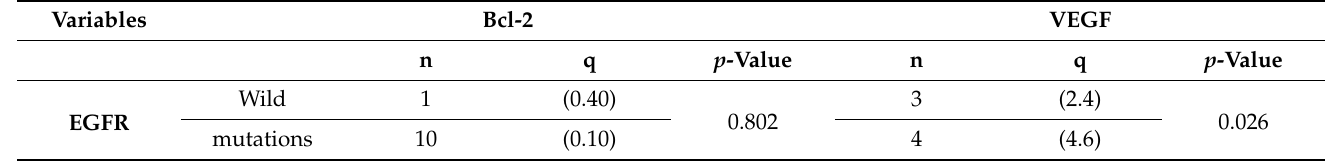
Figure 4. Association of the proliferation index with the expression of VEGFa and Bcl-2. ( A ) graphic and histomorphological presentation of positive correlation between VEGF and the Ki-67 proliferation index in NSCLC patients; ( B ) relationship between Ki-67 proliferative index and bcl-2 expression in NSCLC patients ( C ) graphic and histomorphological presentation of inverse correlation between Bcl-2 and the Ki-67 proliferation index in adenocarcinomas. Table 3. Correlation between EGFR and VEGF and Bcl-2 in 102 cases of advanced lung